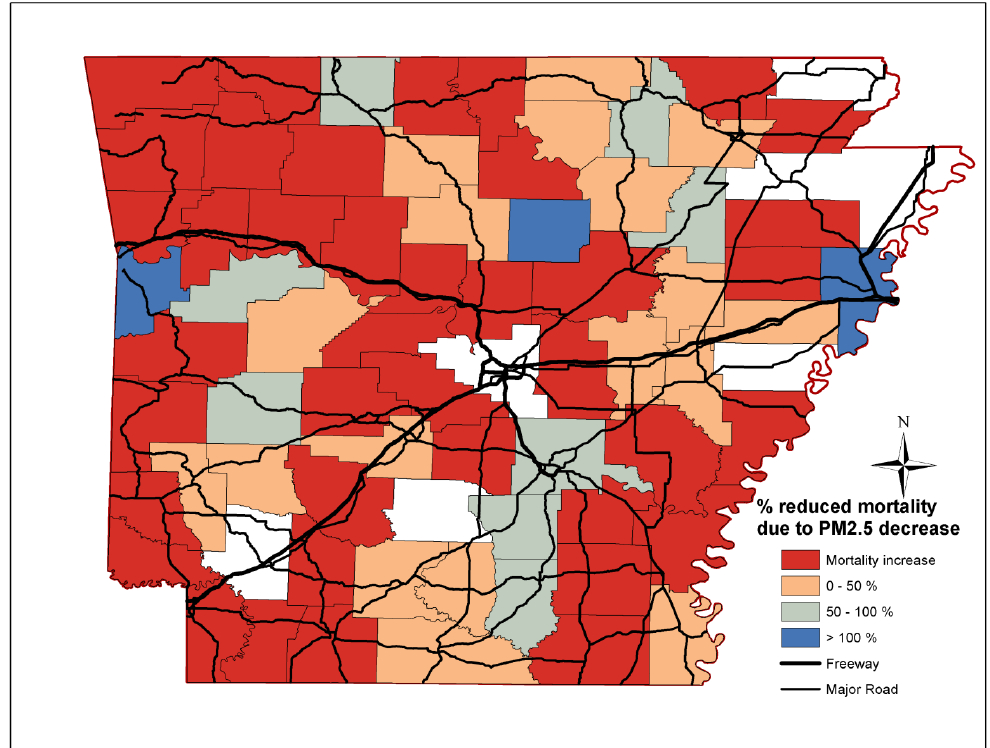
Figure 6. Percentage reduction of lung cancer mortality attributed to PM each Arkansas